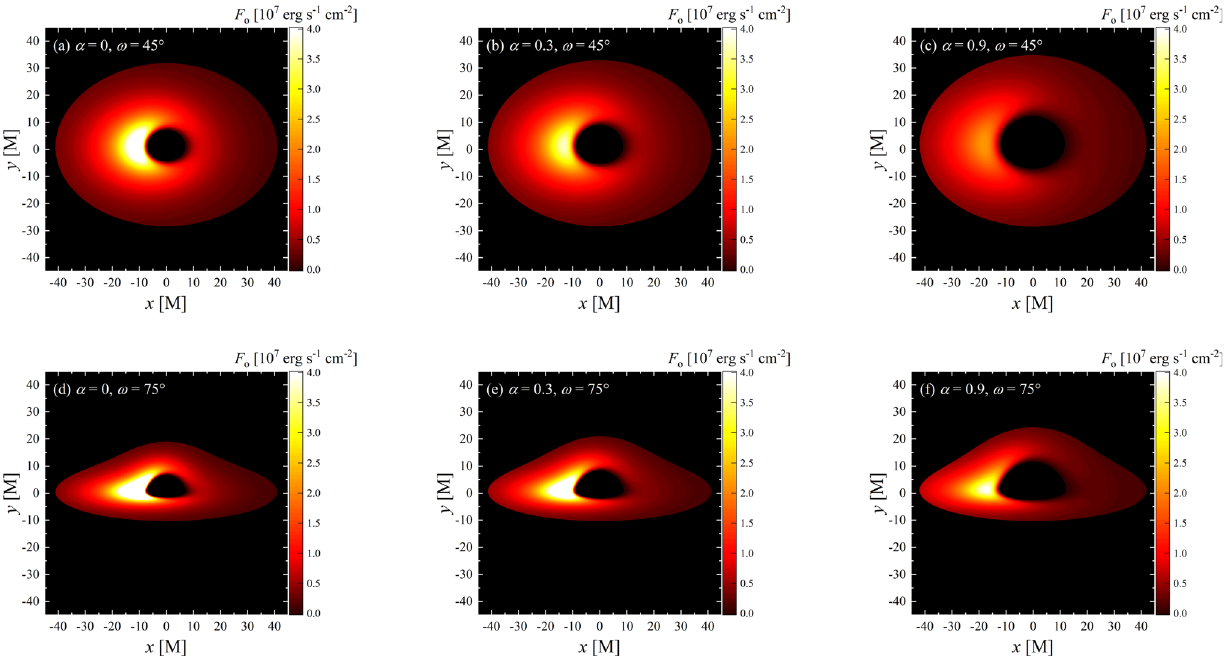
Fig. 9 Continuous distributions of the observed energy flux in the direct images cast by the thin accretion disk around Schwarzschild-MOG BHs under different α and viewing angles. Here, the inner and outer boundaries of the accretion disk are stable circular orbits with radii r = r ms and r = 40, respectively